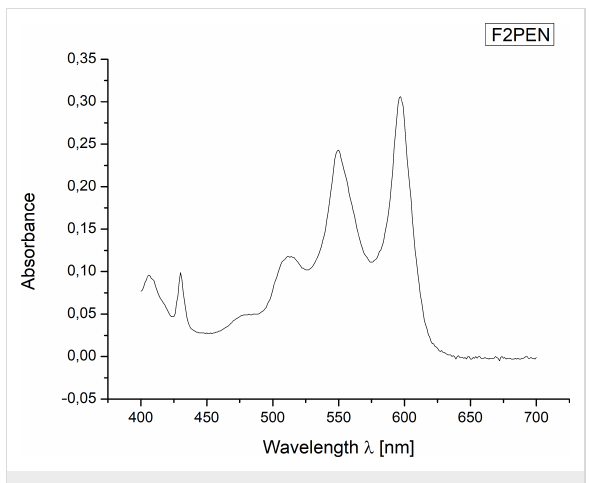
Figure 2: UV–vis spectrum of F2PEN 5 in CH 2 Cl 2 .